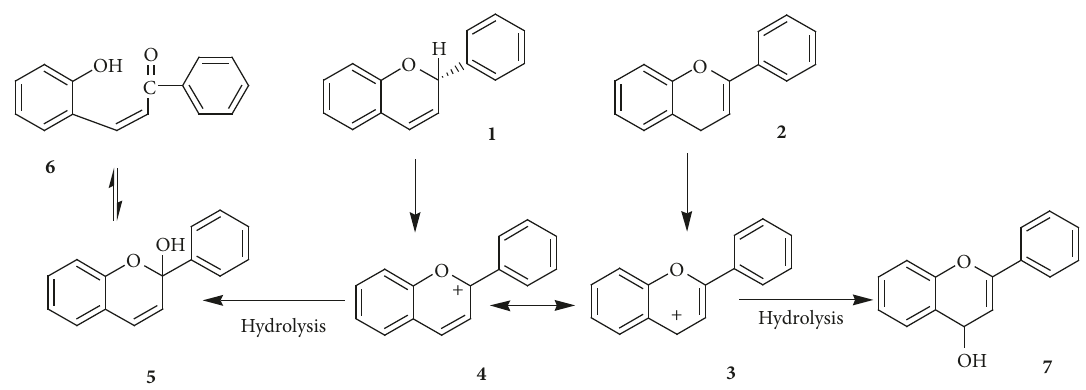
++ Scheme 1: Resonating flavylium salt and flavene structural